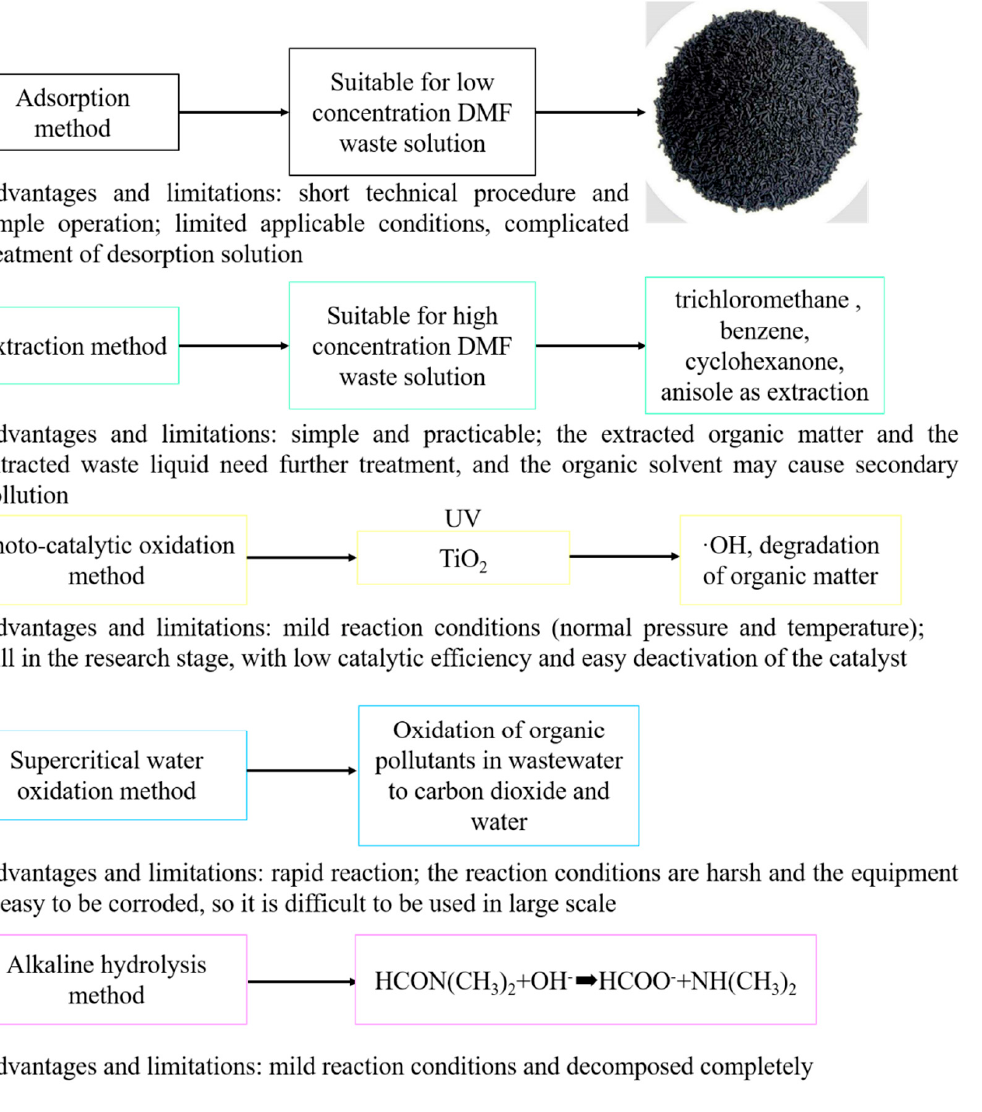
Figure 1. Some existing technologies used for DMF separation and their relative advantages and drawbacks.